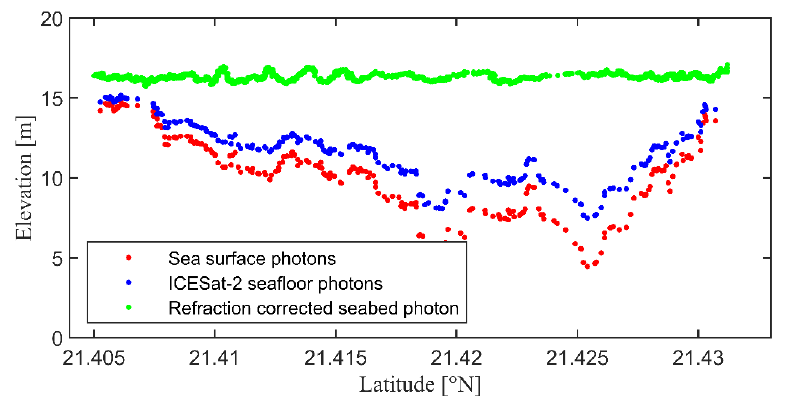
Figure 8. Signal photons on the sea surface (Green) and seafloor (Red) detected from ATL03 for 20190908GT1R and signal photons after refraction correction (Blue) in the Oahu area.